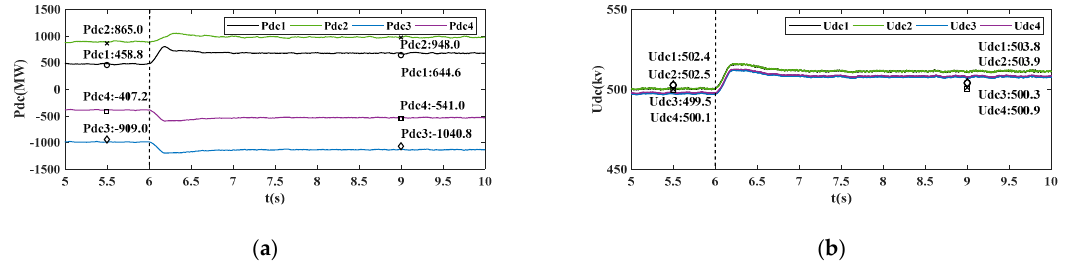
Figure 9. The simulation results in PSCAD. ( a ) Curves of the DC active power with the multi-point voltage control; ( b ) Curves of the DC voltage with the multi-point voltage